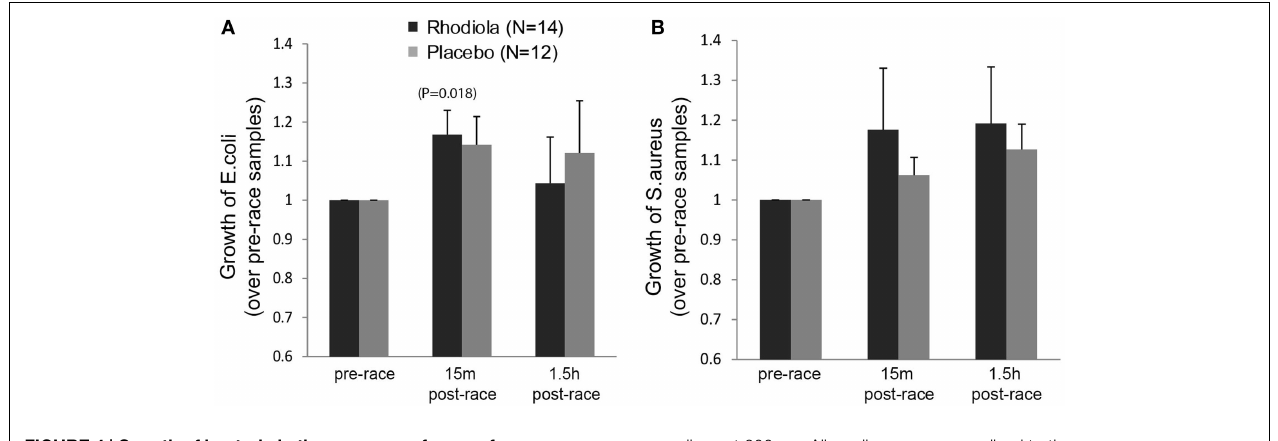
FIGURE 4 | Growth of bacteria in the presence of serum from Rhodiola rosea versus placebo-supplemented subjects . E. coli (A) or S. aureus (B) was incubated with Rhodiola rosea or placebo serum for 24h. Growth of bacteria was determined by measuring absorbance